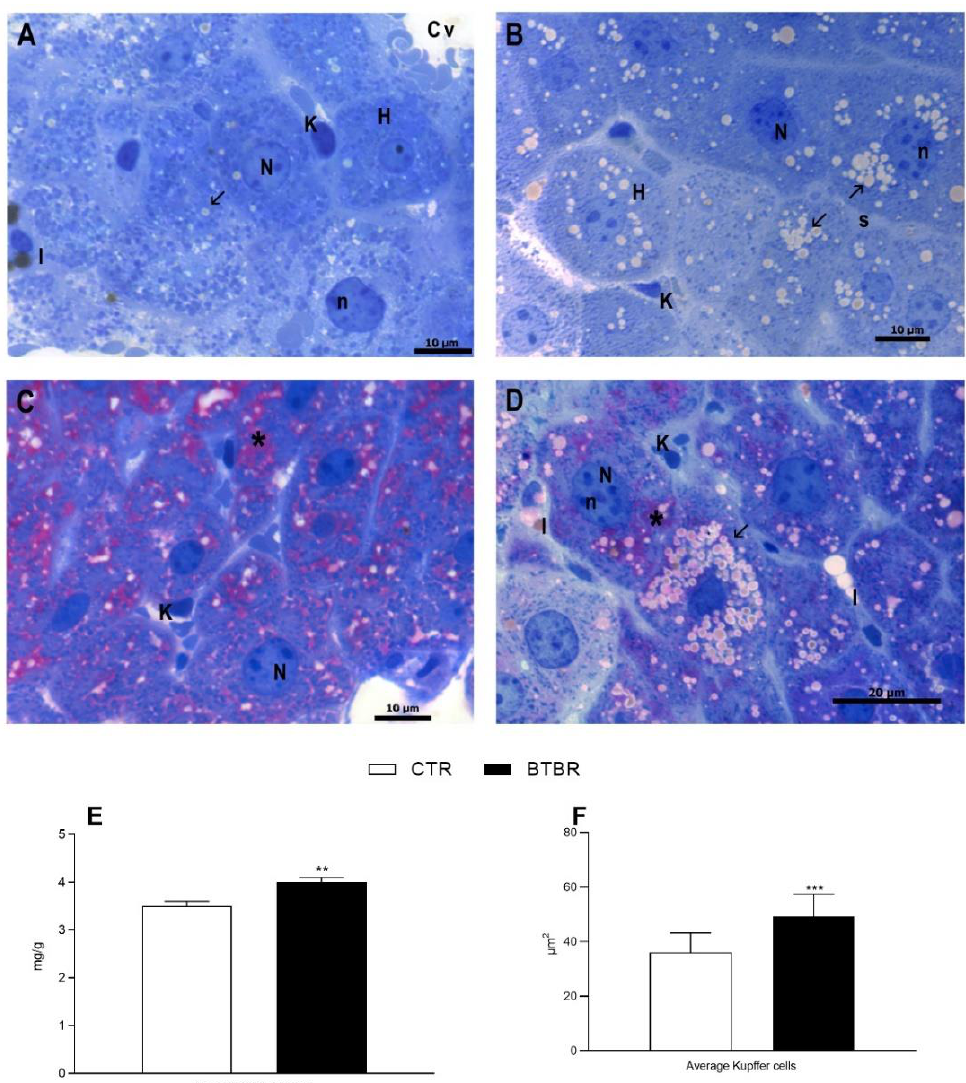
Figure 2. Hepatocytes morphological features of control and BTBR mice. Control group (CTR) ( A , C ); BTBR group ( B , D ). Toluidine blue staining ( A , B ). PAS staining on resin sections ( C , D ). CTR shows hepatocytes (H) arranged around the centrilobular vein (Cv) ( A ). BTBR group shows an increase in lipid drops (arrow), irregularly shaped nuclei (N), nucleolar hypertrophy (n) ( B ). PAS staining of CTR revealed widespread positivity (asterisk) ( C ). BTBR hepatocytes show different grade of positivity (asterisk). K: Kupffer cell, I: Ito cell ( D ). ( A – D ): 100 × magnification. Hepatic lipid content ( E ), and average Kupffer cells ( F ). ** p < 0.01, *** p < 0.001 BTBR vs. Control (CTR).